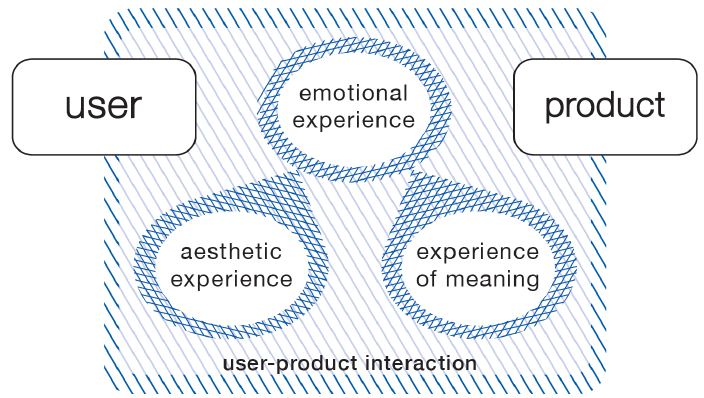
Figure 4. Framework of product experience [24,25].